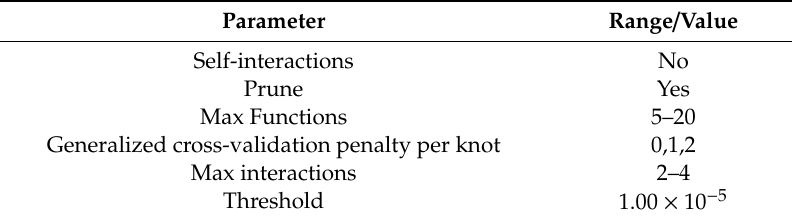
Table 2. Multivariate adaptive regression splines (MARS) e ff ective parameters with their range / value used in the study.